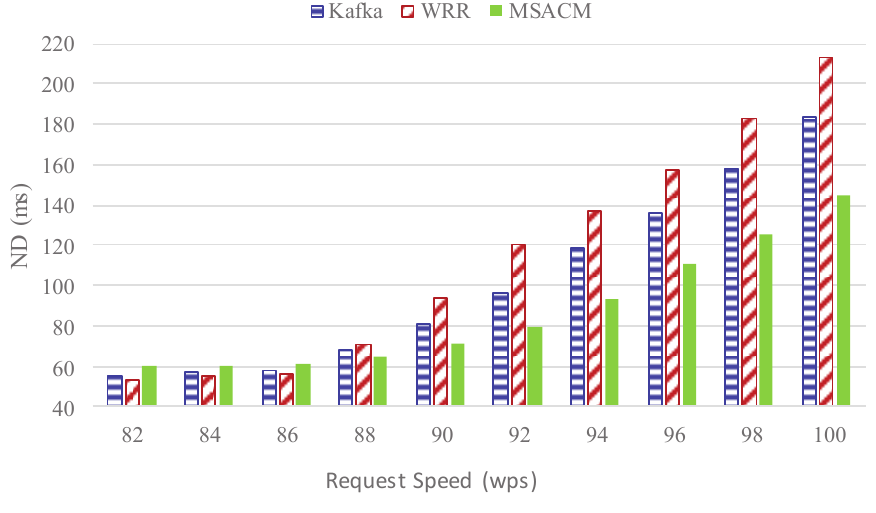
Figure 8. Network delay of various request